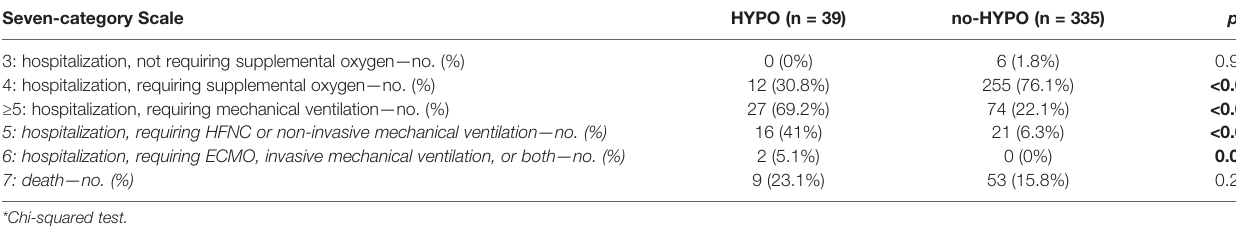
TABLE 3 | The seven-category scale represents the maximum clinical status of patients achieved during the COVID-19 hospitalization. Seven-category